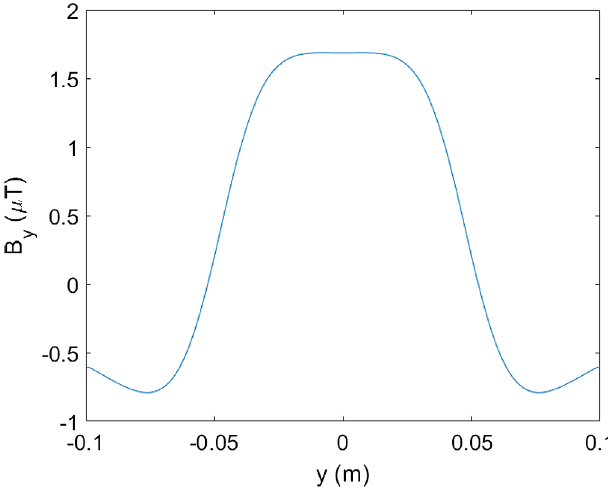
.FIG. 28. B component along the longitudinal coordinate z y